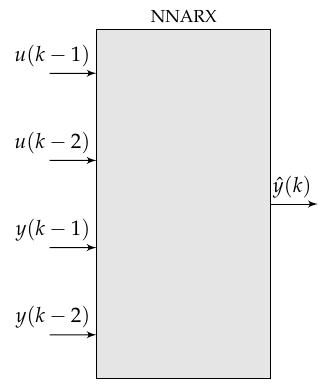
Figure 6. NNARX model structure.